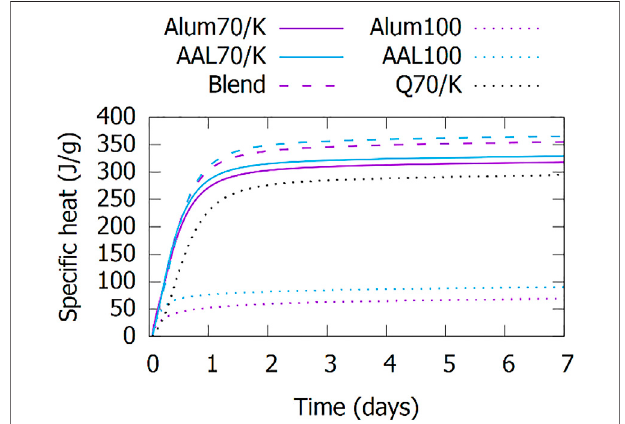
FIGURE 6 | Quanti fi cation of the major phases in the calcined Mytilineos BR and the reacted R 3 -like paste made from it. Only the crystalline part of the DSP and hydrogarnet is taken into